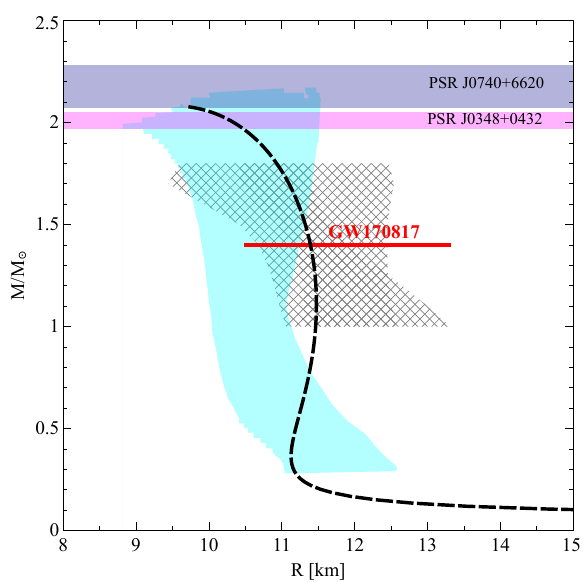
Figure 1. Mass-radius relation for non-rotating neutron stars (NSs) calculated for set B of the induced surface tension Equation of State (IST EoS) [34]. Horizontal bands correspond to the two most massive NSs, e.g., PSR J0348+0432 [36] (magenta band) and PSR J0740+6620 [37] (blue band). The shaded grey area represents the M-R constraint taken from Refs. [38,39], while the constraint depicted as a cyan area was taken from Ref. [40]. The red line represents the allowed range of NS radius, according to GW170817